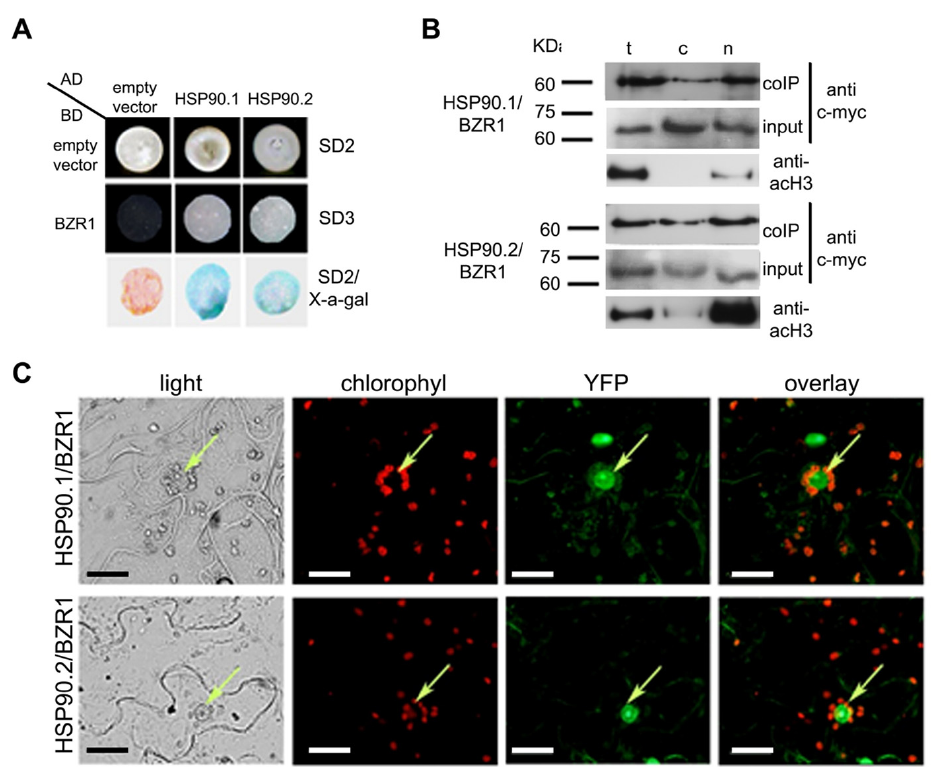
Figure 5. BZR1 interacts with HSP90.1 and HSP90.2. ( A ) Yeast two-hybrid assays using HSP90.1 or HSP90.2 as prey (AD) and BZR1 as bait (BD). Growth of yeast cells co-expressing the indicated construct combinations on SD -Leu-Trp-His (SD3) or on SD2/X-gal media demonstrates interaction. ( B ) Co-immunoprecipitation assays of HSP90.1 or HSP90.2 with BZR1. Total (t), cytoplasmic (c) and nuclear (n) protein fractions were prepared from N. benthamiana leaves transiently co-expressing HSP90.1-HA or HSP90.2-HA with BZR1-c-Myc proteins, and immunoprecipitated with an anti-HA antibody. The immunoblots were probed with anti-c-Myc. For the evaluation of the fractionation the immunoblots were blotted with anti-histone H3 (anti-H3) antibody. ( C ) BIFC interactions assays of HSP90.1 or HSP90.2 and BZR1, in planta. Leaf epidermal cells of N. benthamiana were co-transformed with HSP90.1- or HSP90.2-YFPc and BZR1-nYFP constructs. Arrows indicate the nuclei. Scale bars, 20 µ